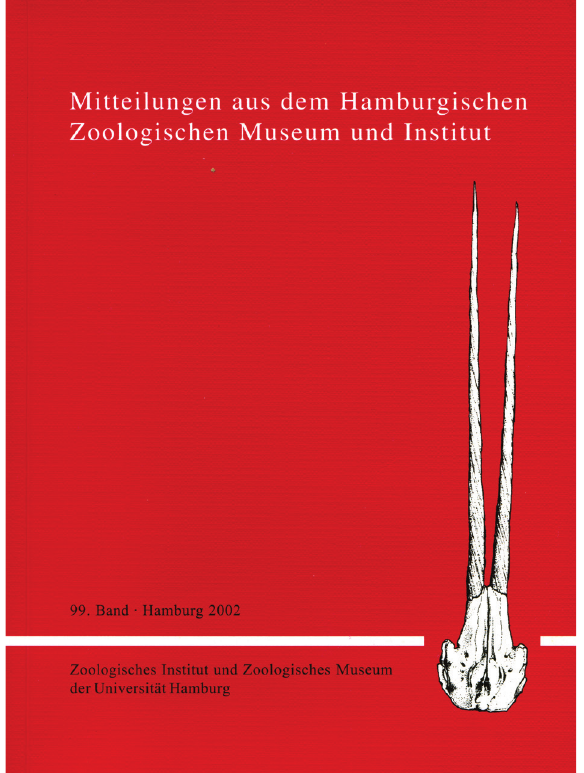
Figure 5. Title page of the newly lanched journal “ Evolutionary Systematics ” in